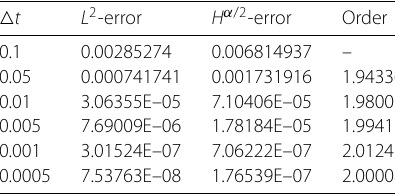
Table 3 The L 2 and H α /2 numerical errors at α = 1.7 for various temporal resolutions u